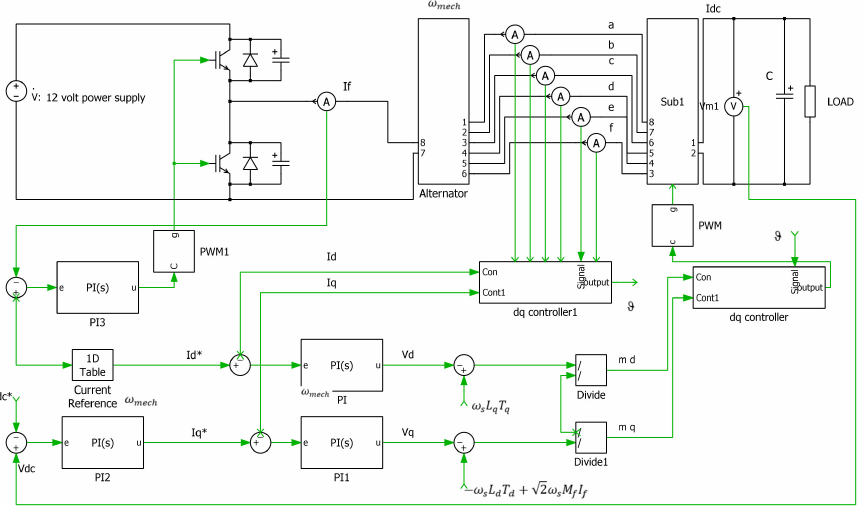
Figure 38. Matlab Simulink setup for the alternator, rectifier, and controller “Reprinted from [47]”. Figure 39 is the experimental setup for the proposed